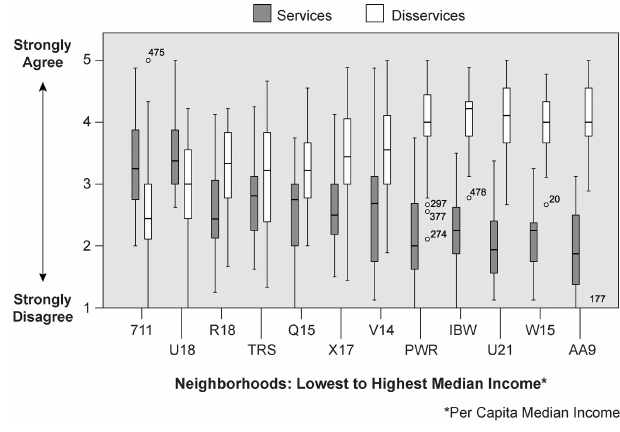
Fig. 1 . Boxplots for overall perceptions of ecosystem services and disservices across the 12 study neighborhoods. The neighborhoods are ordered by per capital median income levels from the U.S. Census for the block groups that comprise the study neighborhoods. For the analysis of how perceived ecosystem services (ES) and disservices (EDS) vary by location, urban core neighborhoods (within 5 miles of downtown Phoenix or within 1.5 miles of other large-city downtowns) include: 711, U18, V14, W15, and X17. Fringe neighborhoods, which have a significant amount of undeveloped land, include AA9, PWR, TRS, and U21 while suburban neighborhoods include IBW, Q15, and R18.